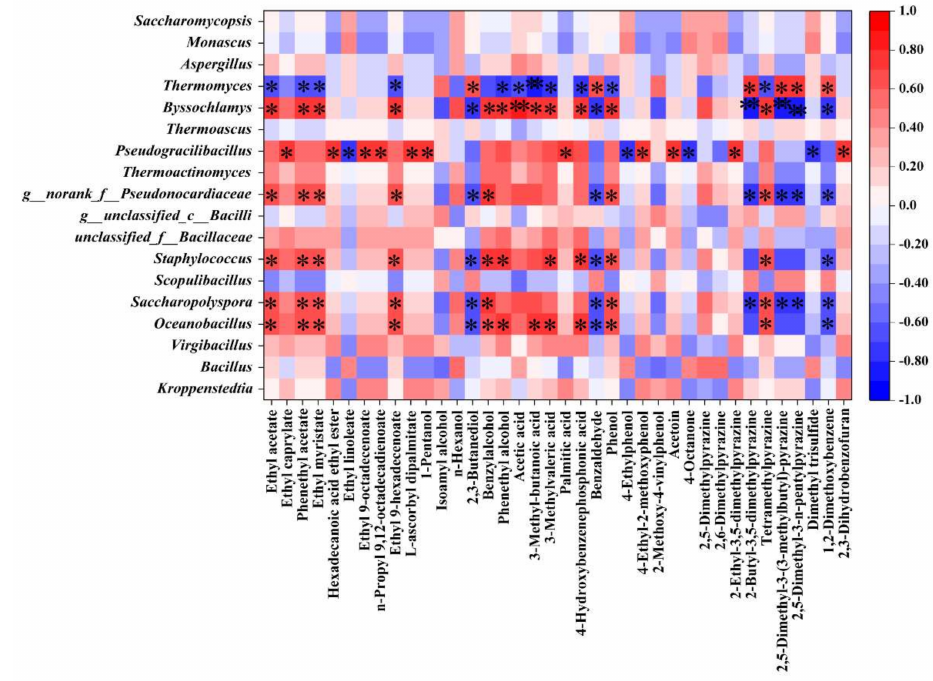
Figure 6. Correlation heatmap between the key flavor compounds and dominant genera. The as‑ terisks show significant correlations (different flavor compounds in Table S1; “*”, 0.01 < p < 0.05; “**”, 0.001 < p < 0.01; “***”, p <